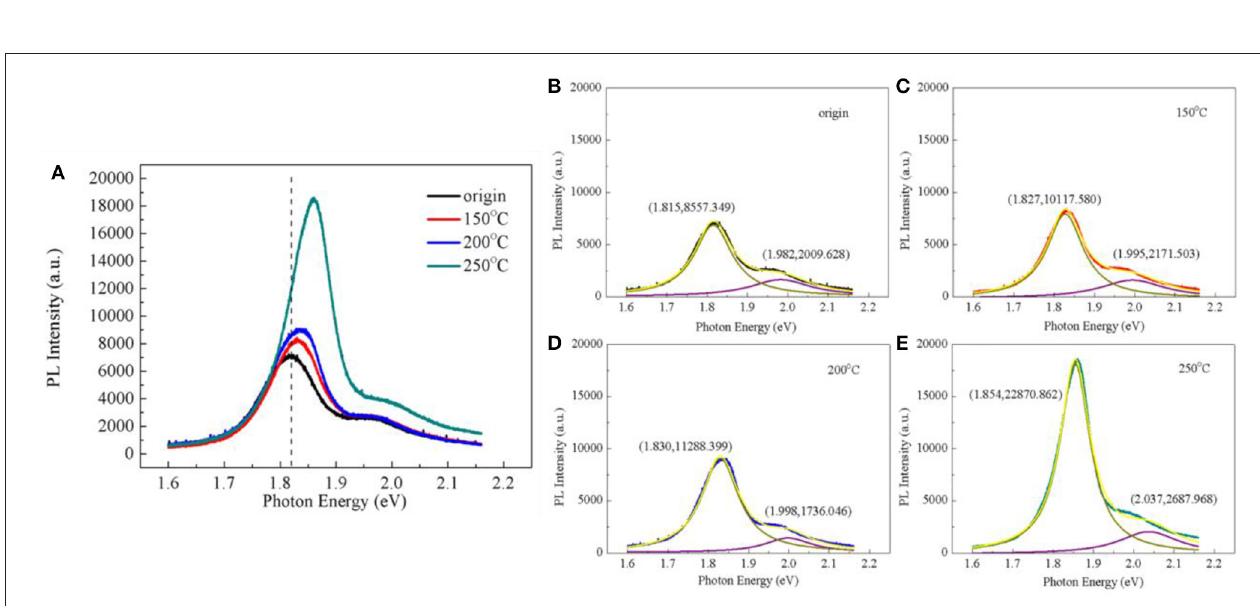
Frontiers in Chemistry |